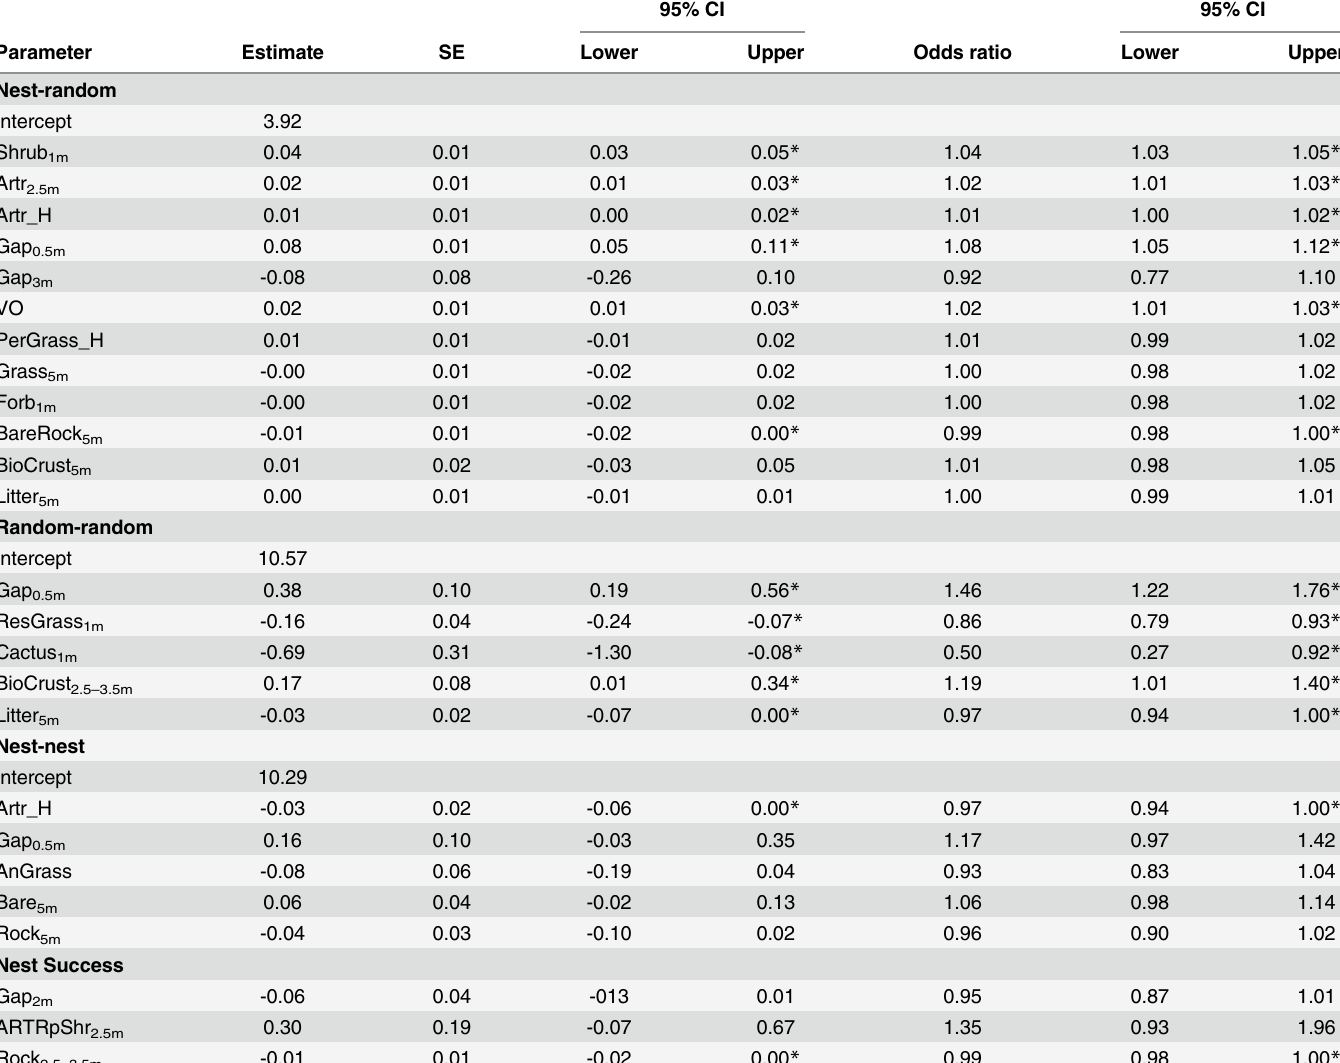
Table 4. Model-averaged parameter estimates and odds ratios with 95% confidence intervals (CI). Data were collected from five distinct study areas ( n = 928 nests and n = 819 random locations) in central and southwestern Wyoming, USA, 2008 – 2014. 95%